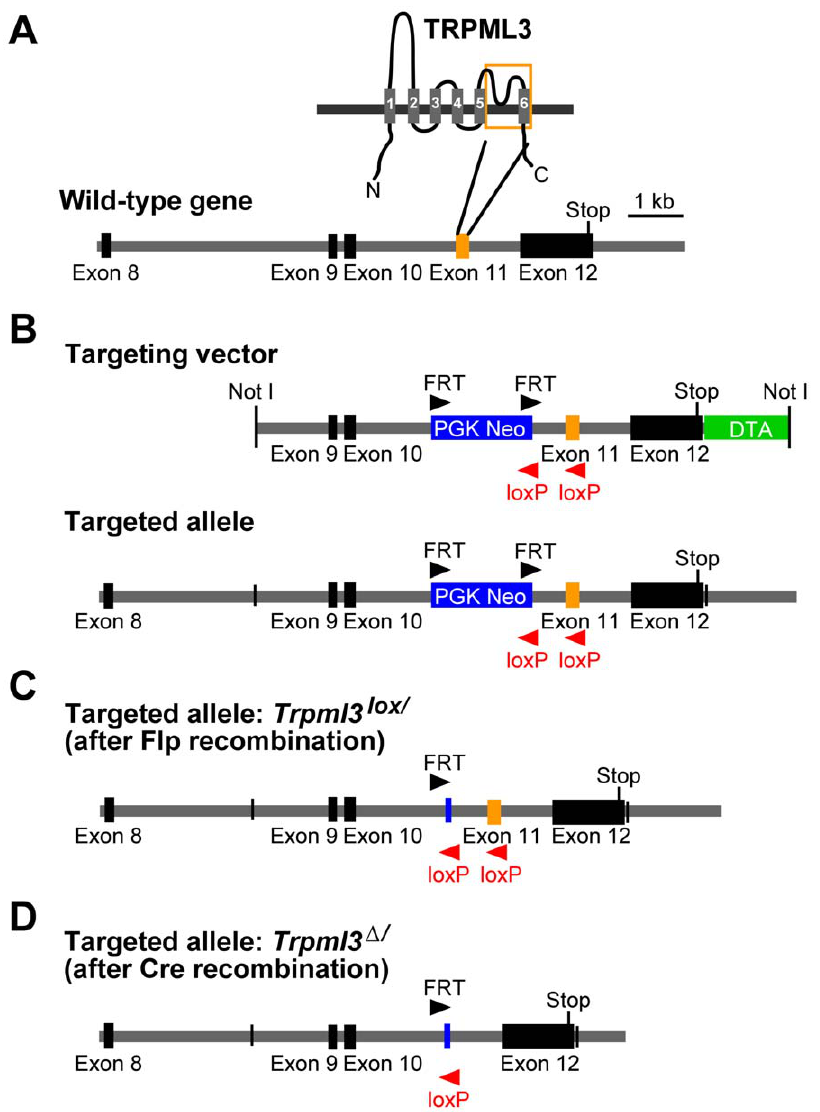
Figure 1. Targeting strategy for disruption of the Trpml3 gene. A, Transmembrane-spanning domains are depicted as grey bars and numbered from 1–6. The orange frame indicates the part of the TRPML3 protein that is encoded by exon 11, which will be deleted (pore loop and TM6). Exons are shown as black and orange bars on the schematic genomic map below. B, Shown are the targeting vector and the targeted allele after homologous recombination. The blue bar represents the PGK promoter-driven neo R expression cassette, which was used for positive selection. The DTA cassette, used for negative selection, is shown in green. The black and red arrowheads symbolize position and orientation of FRT and loxP sites. C, Targeted allele after Flp site-specific recombination in ES cells, resulting in excision of neo R cassette, and leaving one FRT site behind. D, Excision of exon 11 using Cre site-specific recombinase, resulting in disruption of Trpml3 gene.